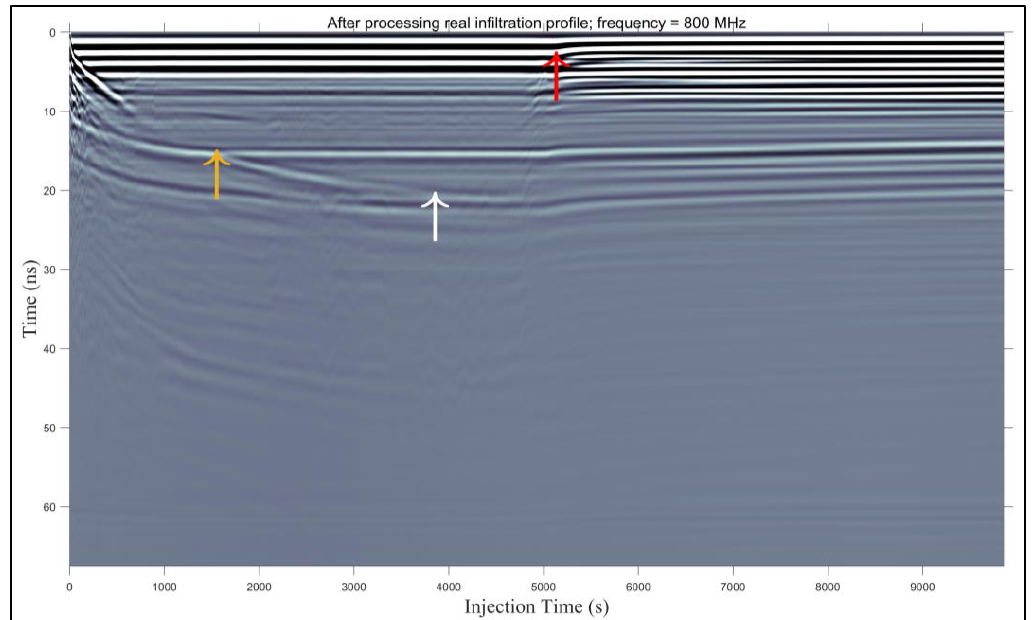
Figure 12. Processed real GPR profile. The orange arrow shows the moment the water front reaches a depth of 0.5 m (1387 s). The white arrow shows the moment the water front reaches the water table (3694 s). The red arrow shows the time (4970 s) when there is no water left inside the wooden box (Author’s own work) [56].